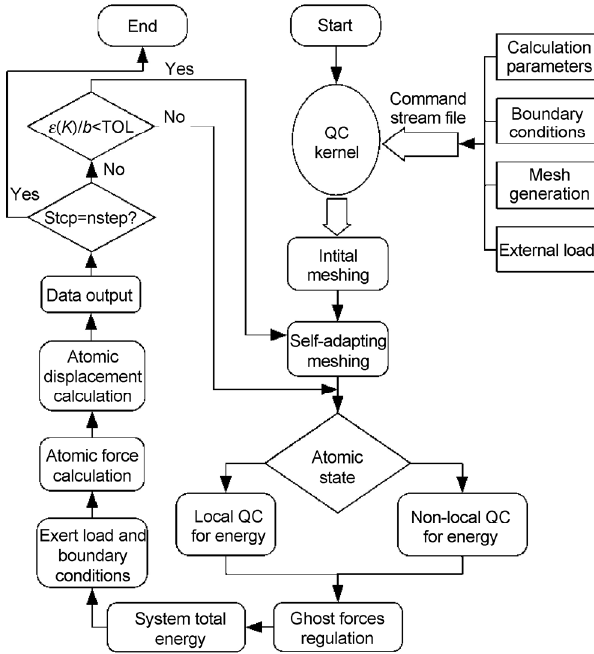
Fig. 5 Flow chart of the QC